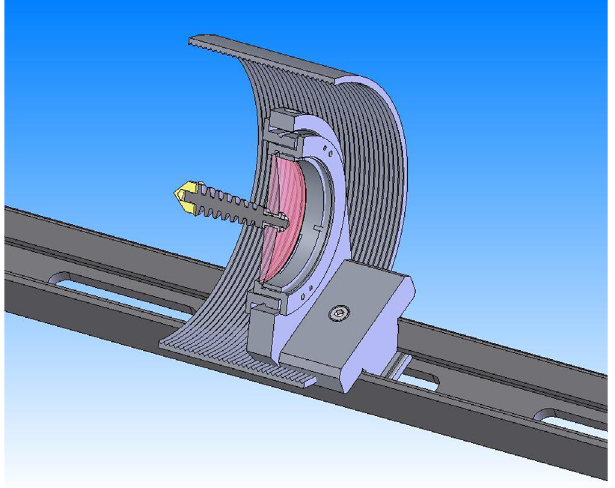
Fig. 5. O2 lens (in pink) carrying the mount of the occulting disk and cone (in yellow).